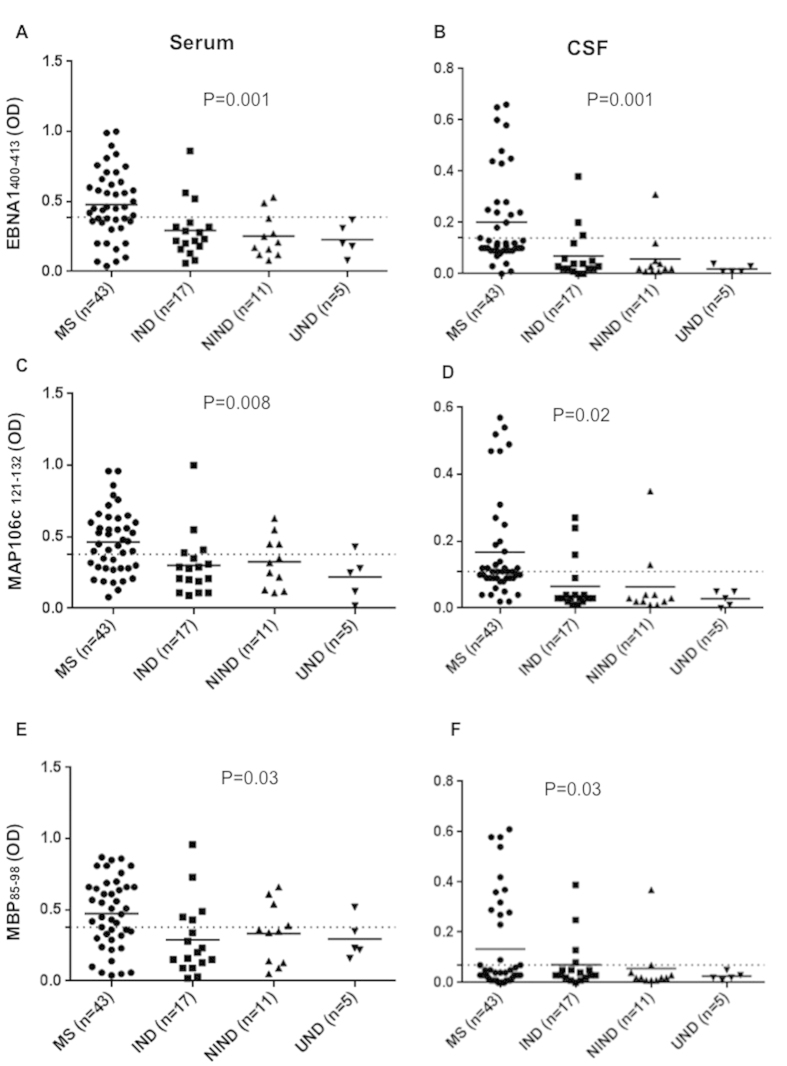
Antibody OD measured by indirect ELISA.Forty-three patients, seventeen IND, eleven NIND and 5 UND were tested for their reactivity against plate-coated with EBNA1400–413, MAP_0106c121–132, MBP85–98, in serum (A,C,E) and in CSF (B,D,F). The horizontal black bars represent the mean value, while p values are indicated by two headed arrows drown on the top of each distribution. Cut-off values for positivity, calculated by ROC analysis, are indicated by dashed lines.